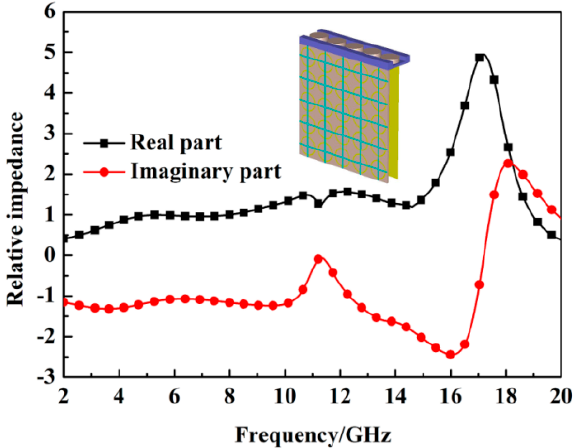
Figure 4. The relative impedance when the rotatable metal plate is parallel to the rest of the layers. In order to explore the mechanism of wideband absorption in the switchable rasorber/absorber when the rotatable metal plate is parallel to the rest of the layers, the surface current distribution at 11 GHz is monitored, as shown in Figure 5. The surface currents on the left and right sides of the top copper metal ring are parallel to the upward direction. This parallel current will cause the charges to accumulate alternately on the upper and lower parts of the copper ring and then result in electric resonance. The surface current on the metal substrate acts downwards, which is opposite to the surface current of the copper metal ring. The opposite surface current on the top copper metal ring and metal substrate form a current circuit, which can produce magnetic resonance [20–23]. The simultaneously produced electromagnetic resonance will lead to the high absorption of the incident wave. The resonant circuit structure of the switchable rasorber/absorber stays stable, and its impedance can match well with the free space at a wide range near the resonant frequency, and finally, lead to the wideband absorption of the incident wave [24].